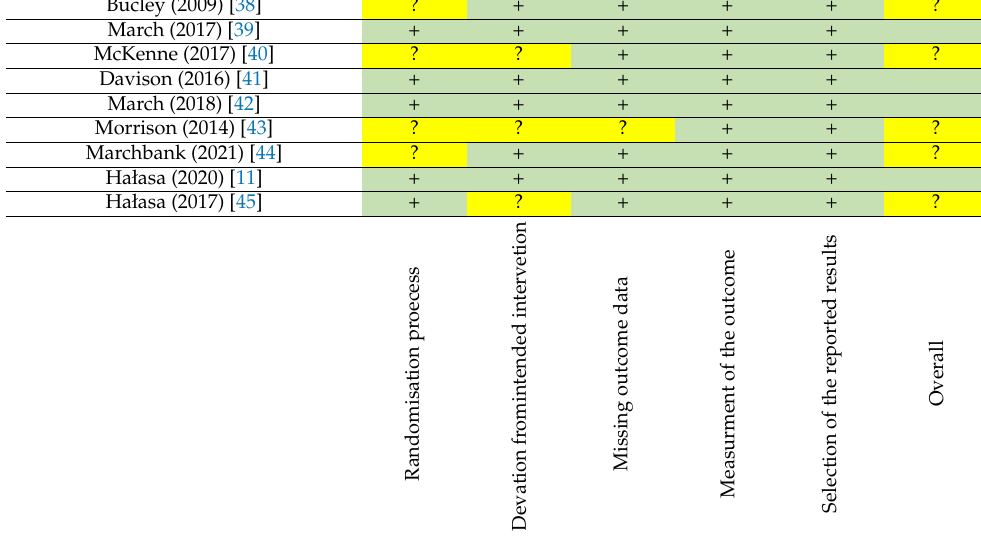
Legend: + and green color: Low risk of bias; ? and yellow color: Unclear risk of